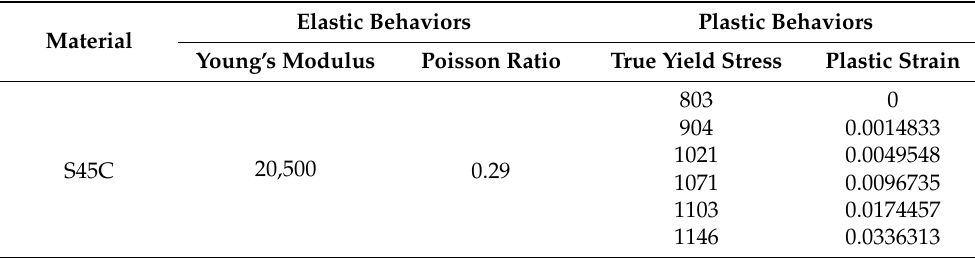
Table 4. Material property data of jigs and bolts applied to the finite element model.